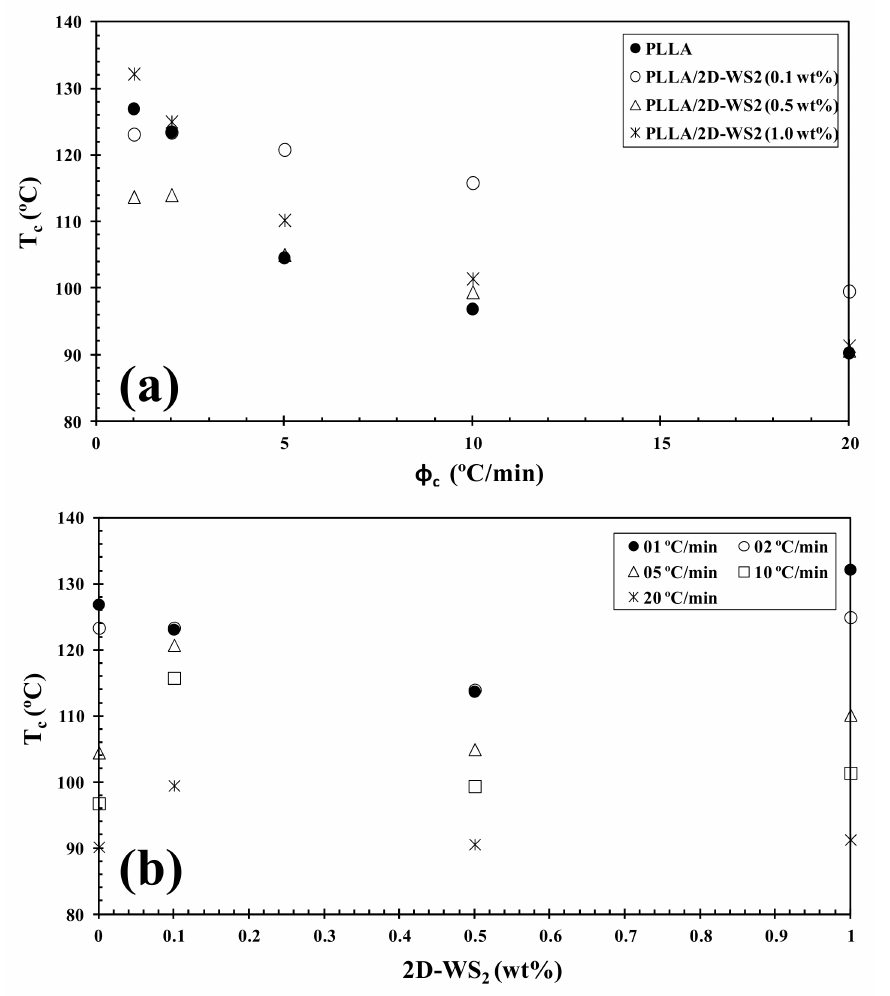
Figure 8. Variation of the melt-crystallization temperature (T c ) for PLLA/2D-WS 2 nanocomposites with ( a ) cooling rate and ( b )